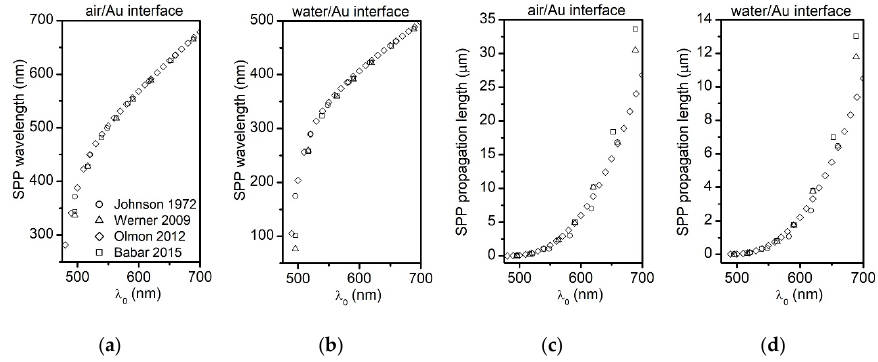
Figure 3. Four di ff erent sets of Au relative permittivity coe ffi cients were used as a function of the Figure 3. Four different sets of Au relative permittivity coefficients were used as a function of the incident photon wavelength: ( a ) the SPP wavelength at the air/Au interface; ( b ) the SPP wavelength incident photon wavelength: ( a ) the SPP wavelength at the air / Au interface; ( b ) the SPP wavelength at the water/Au interface; ( c ) the SPP propagation length at the air/Au interface; and ( d ) the SPP at the water / Au interface; ( c ) the SPP propagation length at the air / Au interface; and ( d ) the SPP propagation length at the water/Au interface [37 – 40] . propagation length at the water / Au interface